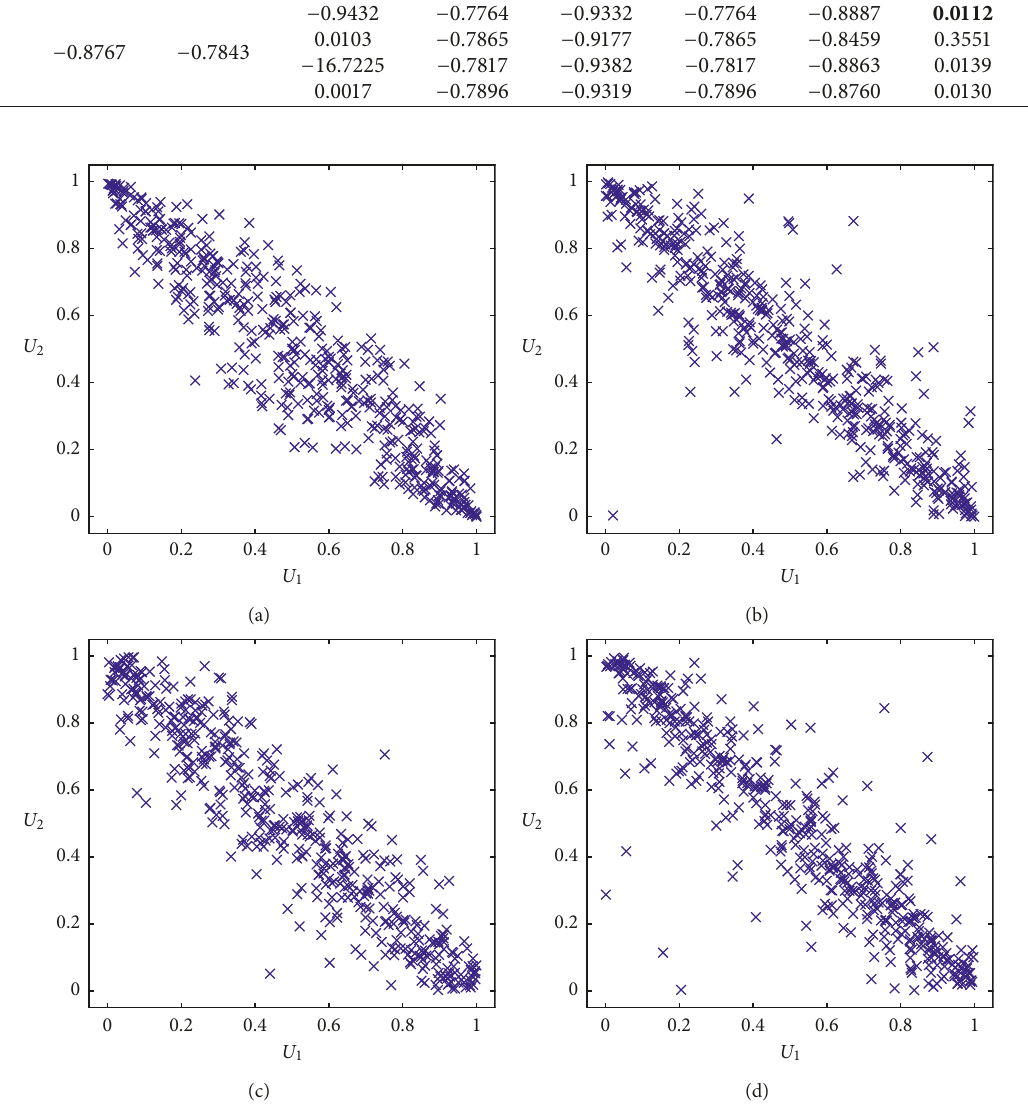
Figure 8: Scatter plots of simulated pairs using different copulas. (a) Gaussian copula. (b) Plackett copula. (c) Frank copula. (d) No.16